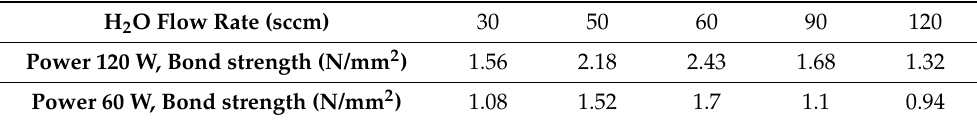
Figure 5. Emission intensities of the OH (307 nm) and H bonds (486 nm) as a function of the application of pressurized H 2 O plasma. Table 1. Heterogeneous bond strengths after plasma treatment.